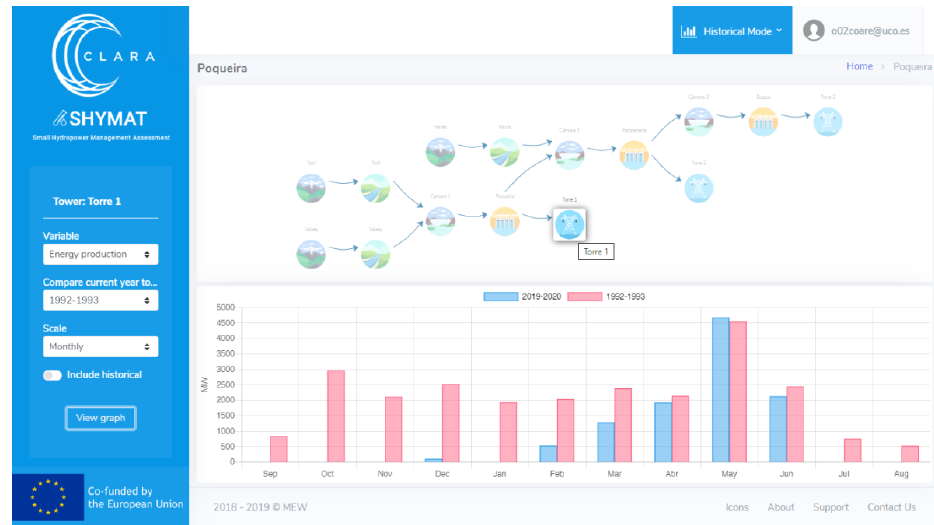
Figure 6. Example of the visualization of the SHYMAT web-user interface. Historical mode outputs: The power grid element is selected in the topology panel and a graph showing the monthly energy production data for the hydrological years 1992/93 (red) and 2019/20 (blue) appears on the screen. On the other hand, the main outputs of the forecast mode are: